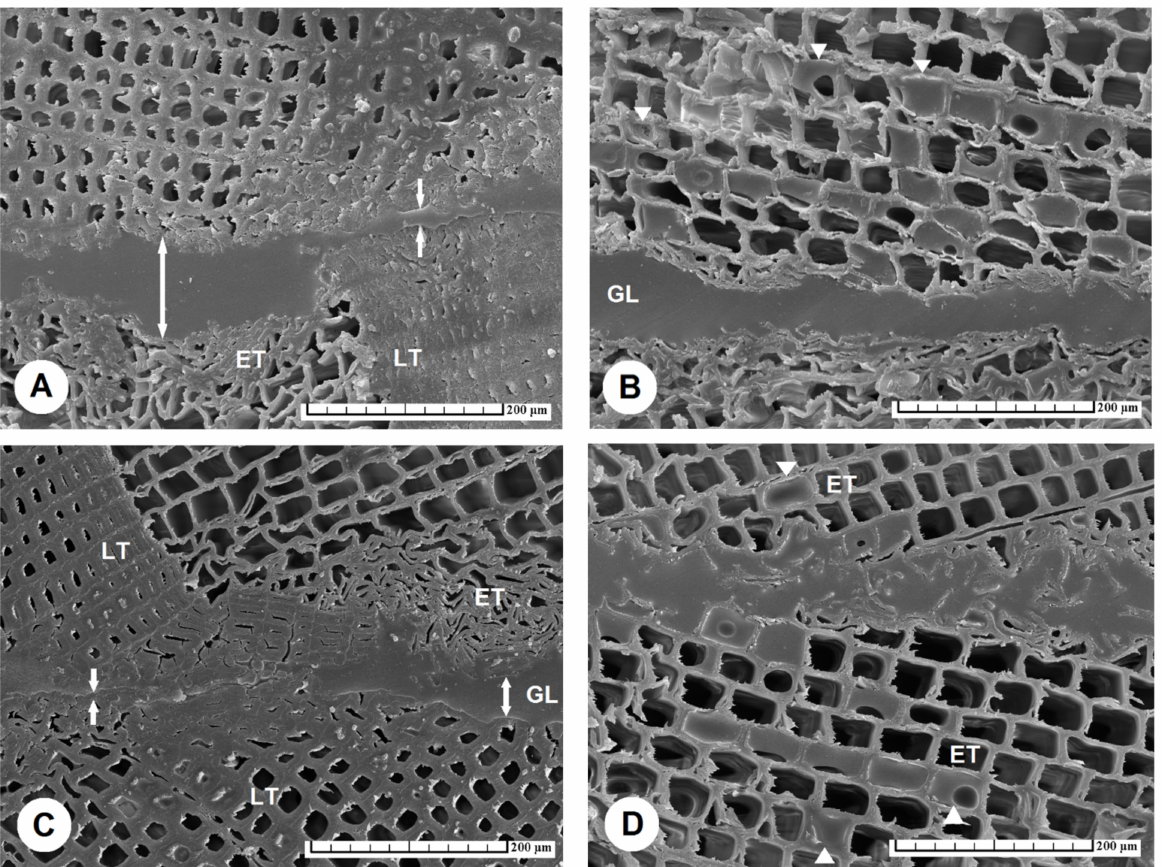
Figure 3. A glued joint of spruce TM wood with PVAc glue has a glue line (GL) with a large and uneven thickness, showing: ( A ) a significant difference in the thickness of GL for earlywood